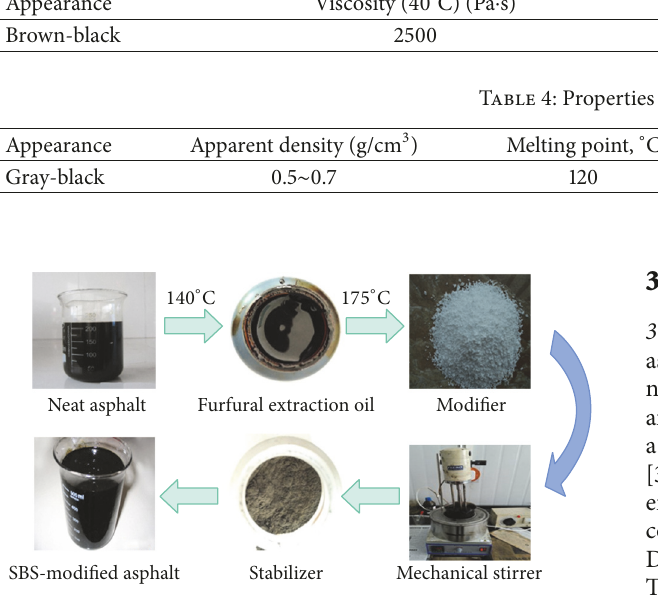
Figure 1: Preparation process of SBS-modified